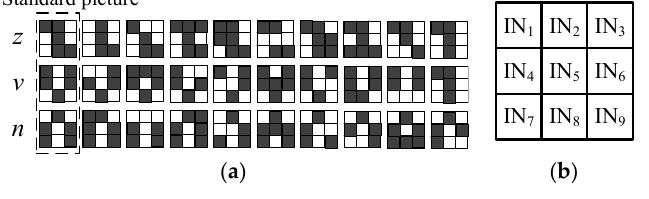
Figure 4. Picture dataset: ( a ) z , v , and n character pictures; ( b ) pixel order of pictures.